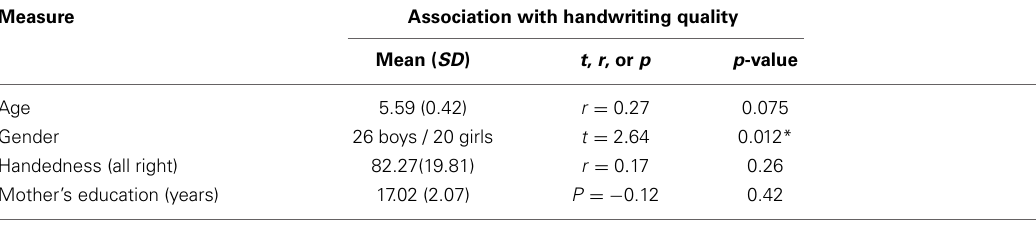
Table 1 | Demographics and